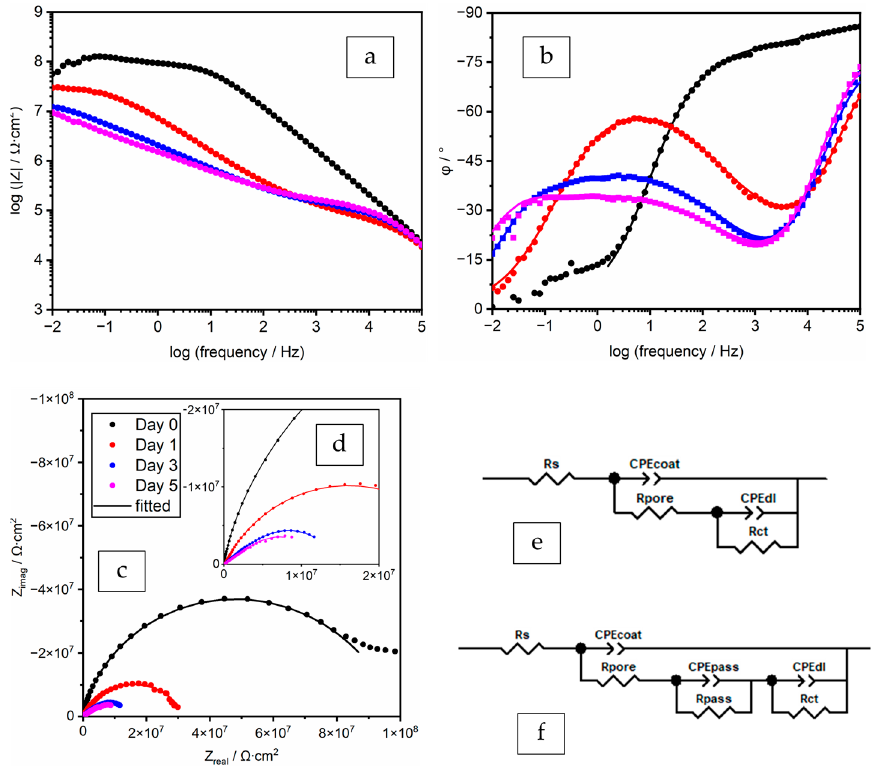
spectra of Day 1 showed a transient status of the passivation initiation, in which the pas- sivation layer sealed the defects at the coating-substrate interface. As suggested by the large R pass value, the passivation layer formed instantaneously when the electrolyte reached the interface through a small number of defects in the coating film. The compo- nent R pore , which is usually in series with the two pairs of electrical components, i.e., CPE pass and R pass , CPE dl and R ct , as shown in Figure 4f, is not distinguishable from the R pass and R ct by the data fitting process. The fitting process was able to succeed only by remov- ing R pore from the EEC. On Days 3 and 5, the decreasing CPE coat value indicated the repair- ing function of the additive. At the same ZP dosage of 2%, the polyester coating (Figure 5) outperformed the Figure 5. EIS spectra ( a – c ) and the Nyquist plot with the enlarged high-frequency region ( d ) and epoxy coating (Figure 6), as indicated by the lower coating film CPE values, higher re- sistance values, and more slowly decreasing resistances. EECs for data fitting ( e , f ), coating prepared by the formula ZP–02%-PB. Table 5. Fitted values of EEC components, ZP 2% in PB (ZP–02%-PB).